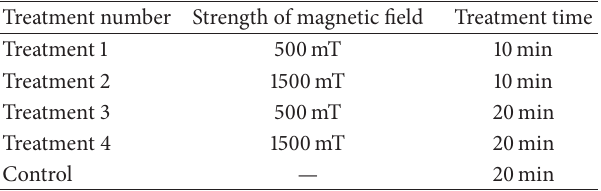
Table 1: Different treatments used in this research. Treatment number Strength of magnetic field